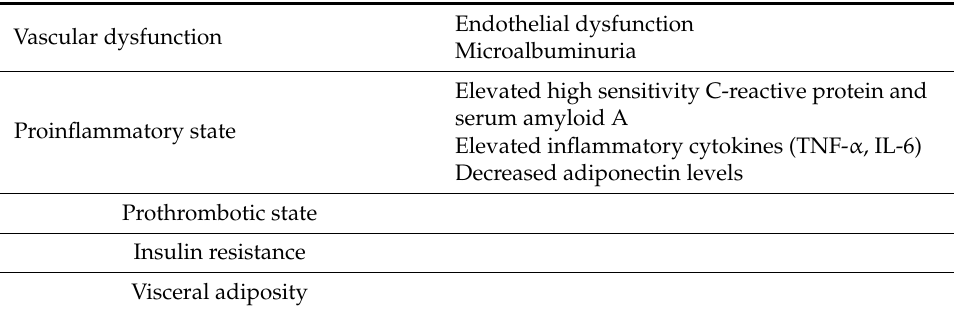
Endothelial dysfunction Microalbuminuria Elevated high sensitivity C-reactive protein and serum amyloid A Elevated inflammatory cytokines (TNF- α , IL-6) Decreased adiponectin levels